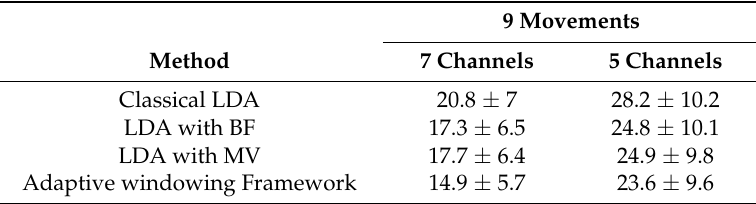
Table 7. Mean ± SD of the classification errors for the case of 9 movement classes with 5- and 7- EMG channels with the classical LDA, LDA with MV, LDA with BF and our proposed adaptive windowing